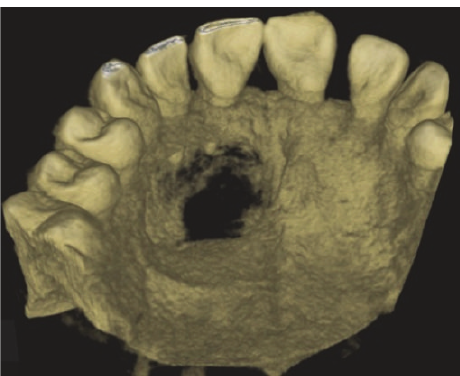
Figure 9: Surgical incision on palatal